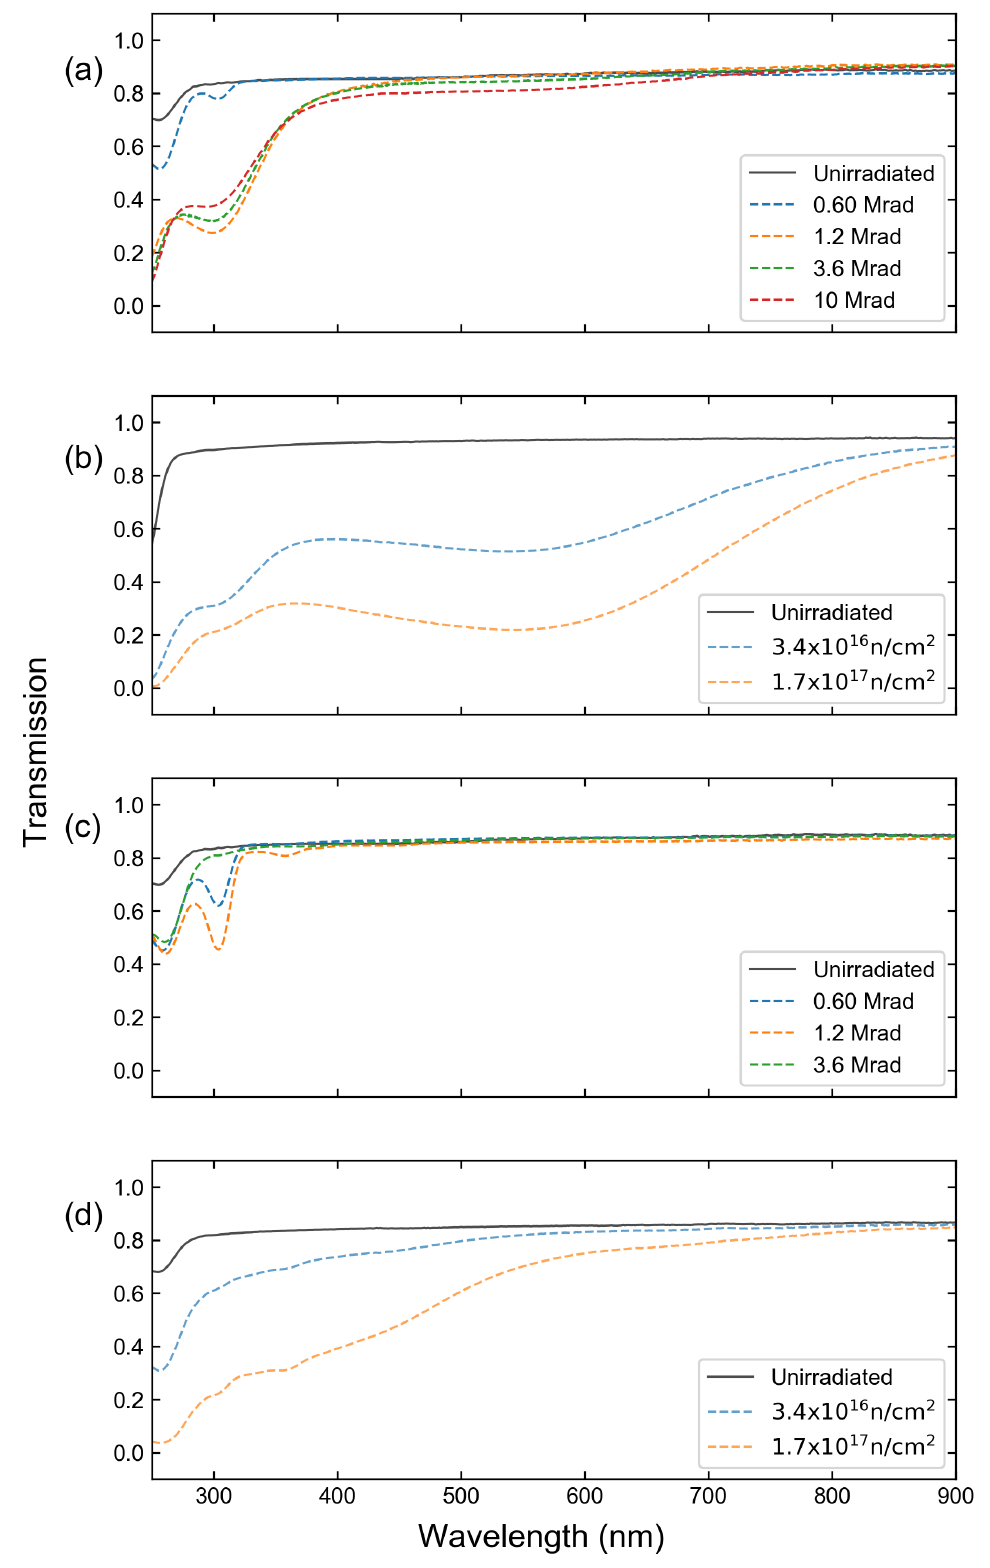
Figure 1. Transmission of ( a ) gamma-irradiated Infrasil-302, ( b ) neutron-irradiated Infrasil-302, ( c ) gamma-irradiated sapphire, and ( d ) neutron-irradiated sapphire